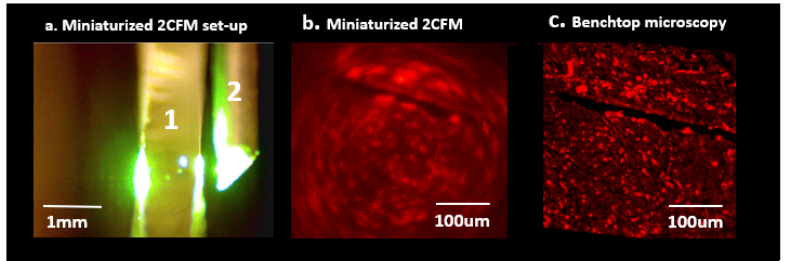
Figure 3. ( a ) Miniaturized 2-color fluorescence microscopy (M-2CFM) of stained tissue sections placed on a slide (1) using a side-imaging GRIN lens probe (2). ( b ) M-2CFM of red-fluorescent labeled macrophages. ( c ) Corresponding benchtop fluorescence image of the same slide used to quantify M-2CFM imaging capabilities. In-plane resolution was sufficient to view individual 10 μ m diameter cells, and overall field of view was ~400 × 400 μ m.